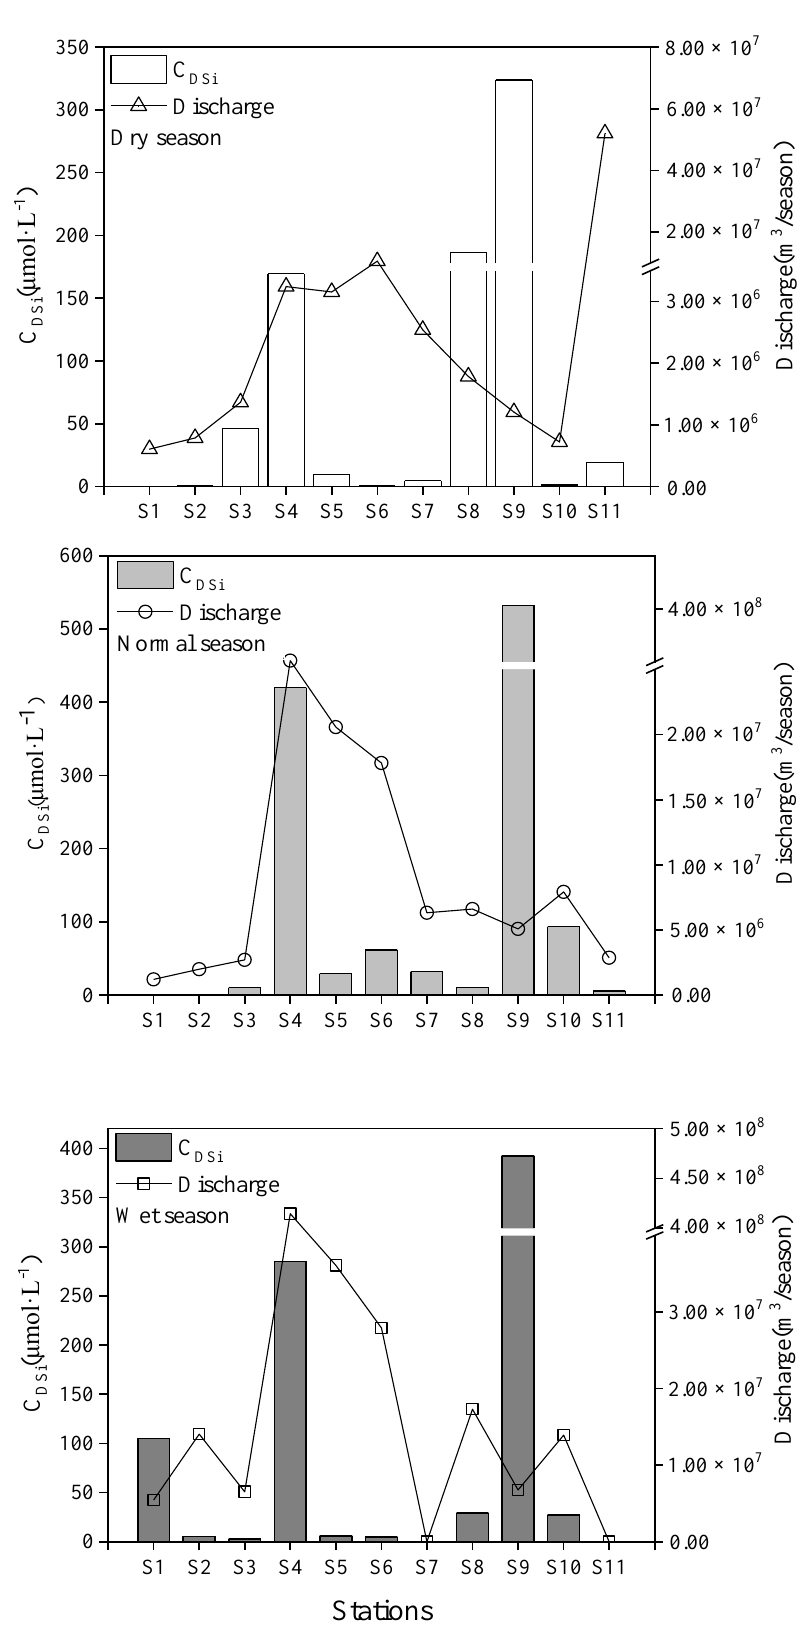
Figure 4. Seasonal concentration (C DSi ) and discharge in Zhanjiang Bay.